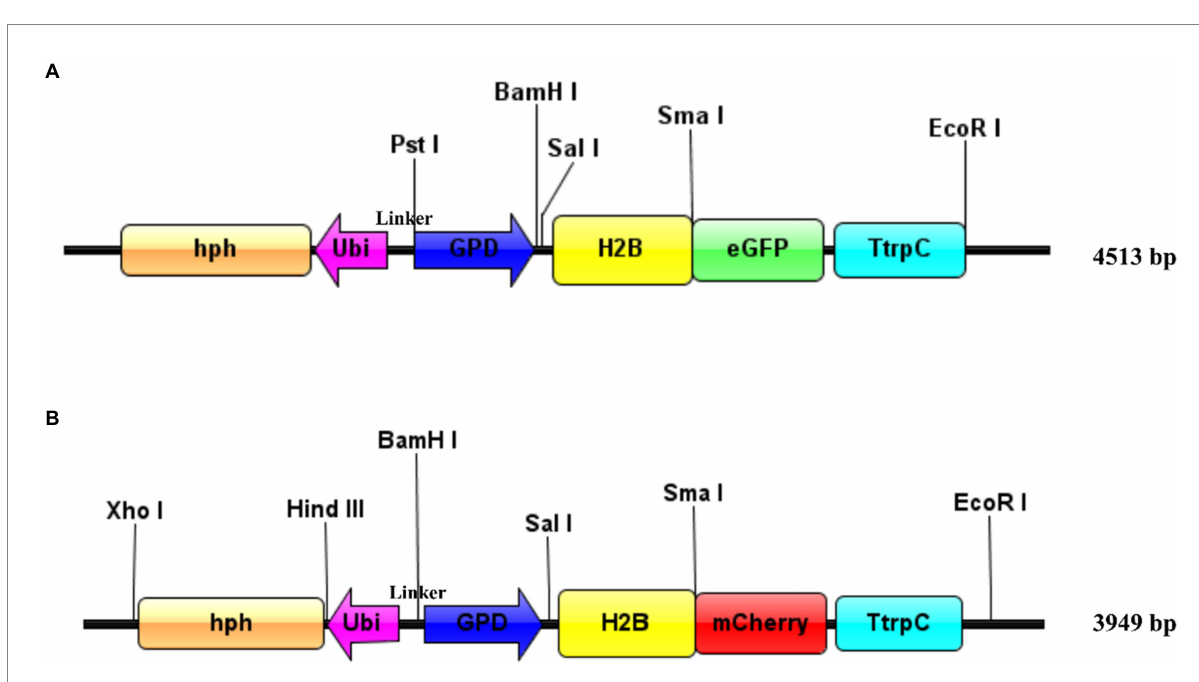
FIGURE 1 Schematic of plasmid design for transformation. (A) pEH2B vector. Enhanced green fluorescent protein was used as reporter gene. (B) pMH2B vector. MCherry was used as reporter gene. Both the vectors carrying Morchella importuna histone H2B (M04M26Gene04385) genomic sequence were fused with eGFP or mCherry. The fused fluorescent gene expression was initiated by the GPD promoter from M. importuna and terminated by the tryptophan synthase gene terminator from Aspergillus nidulans. The hygromycin resistance gene (hph) expression was initiated by the M. importuna ubiquitin (ubi) promoter. Unique restriction enzyme recognition sites used for linearization were marked above the vectors, and the vectors are easy to modified in the restriction site. The schematic was generated by IBS web server (http://ibs.biocuckoo.org/online.php; Liu et al.,